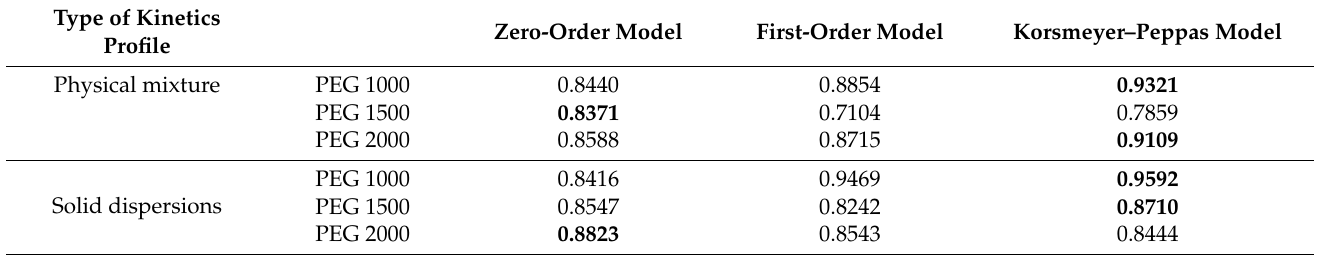
Table 5. Coe ffi cient determination (R 2 ) for di ff erent models of the dissolution pro fi les of the samples. Table 5. Coefficient determination (R 2 ) for different models of the dissolution profiles of the